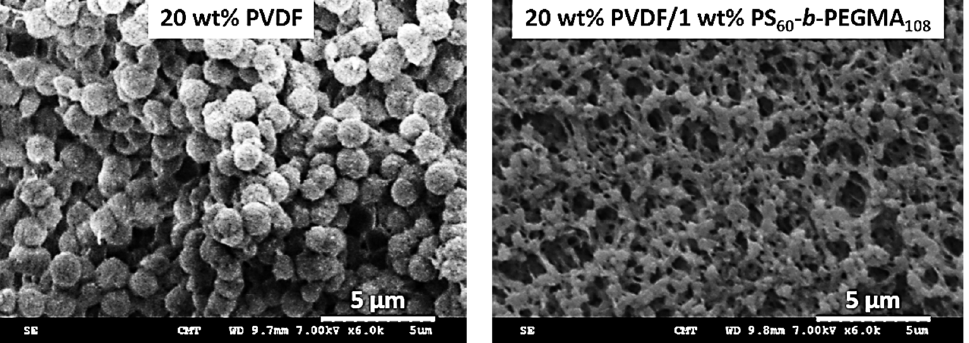
Figure 5. Influence of the addition of 1 wt% PS 30 - b -PEGMA 68 copolymer to a casting solution con- taining PVDF (NMP as solvent) on the cross-sectional morphology of LIPS membranes (T dissolution : 40 °C; Solvent content fixed: 75 wt%; non-solvent: DI water; casting thickness: 300 µm). Left image partially reproduced with permission from [357]. Copyright 2014 Elsevier.